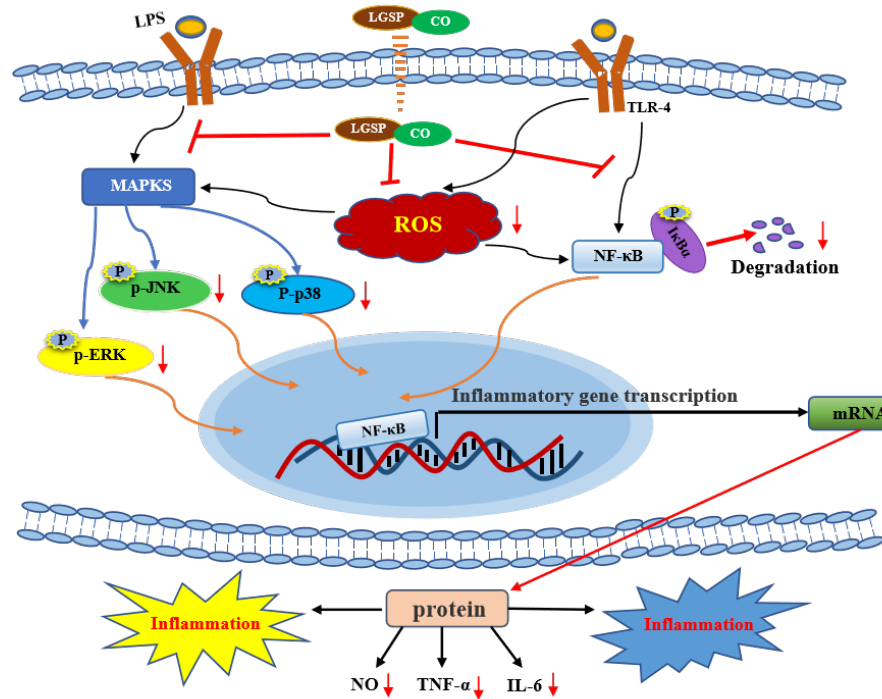
Figure 7. The underlying synergistic anti-inflammatory mechanism of LGSP and CO.